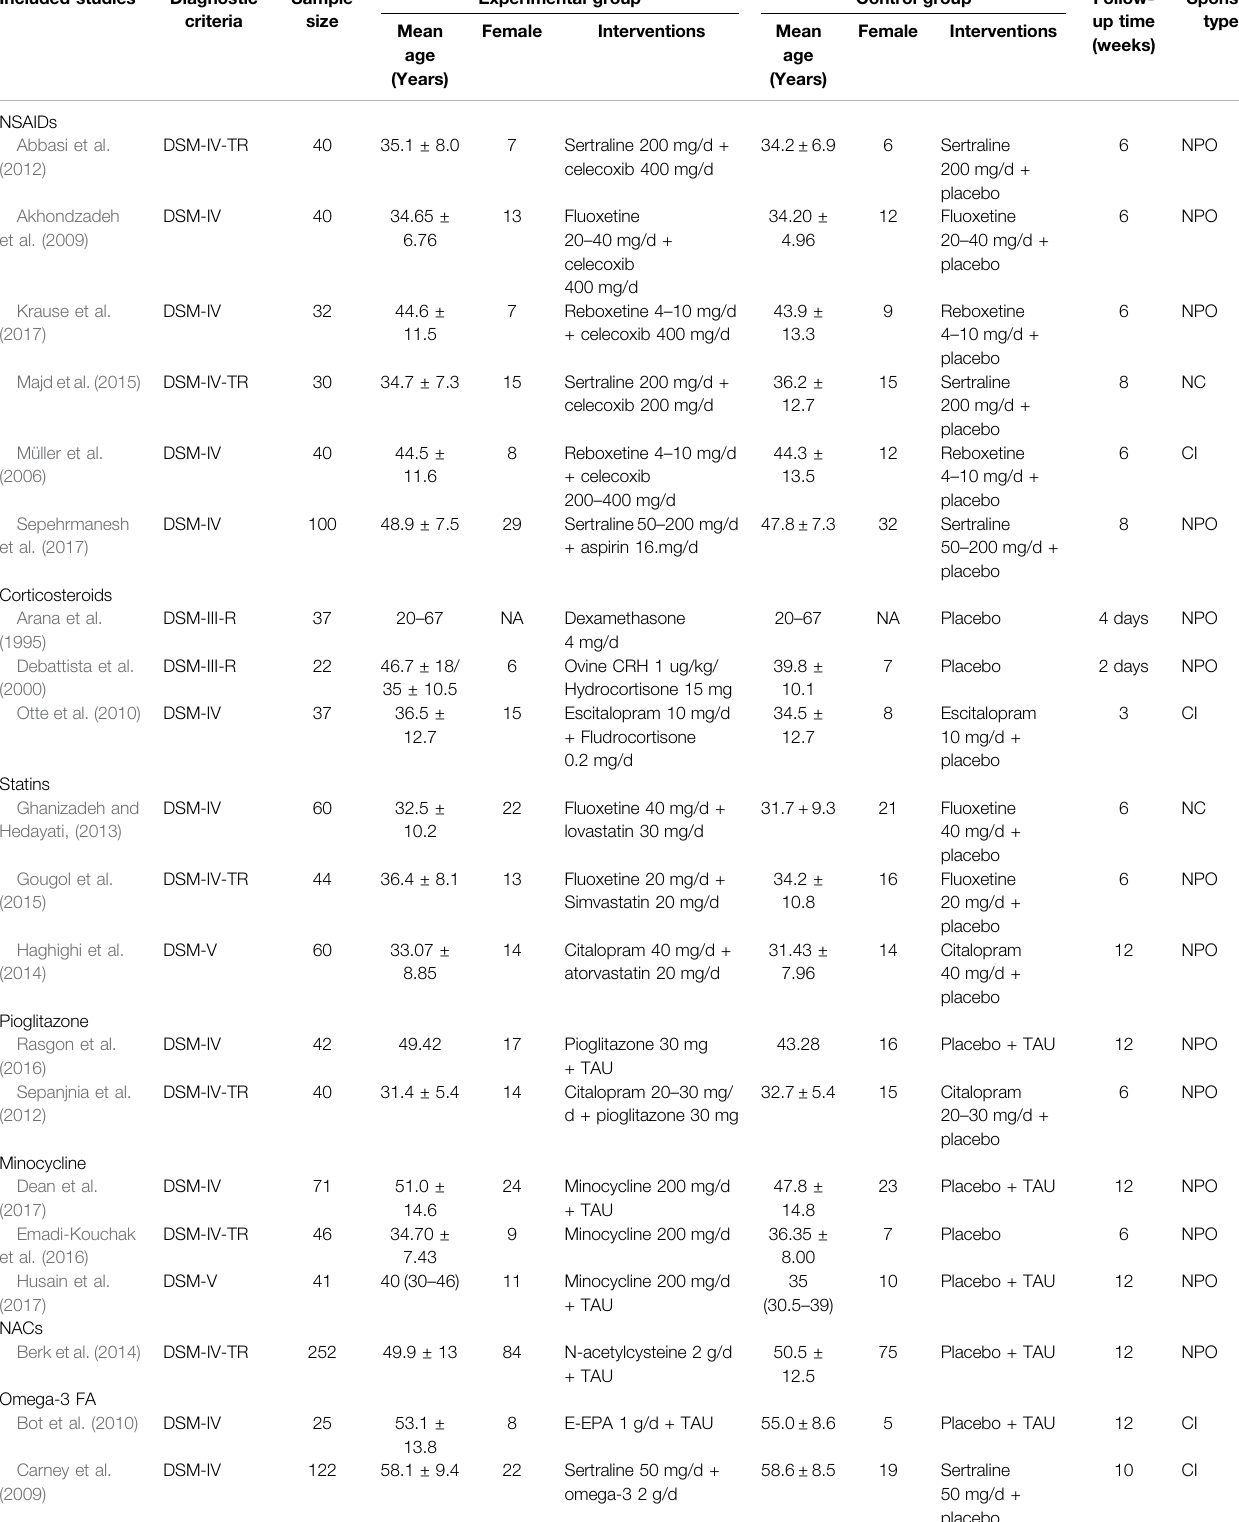
TABLE 1 | Characteristics of included